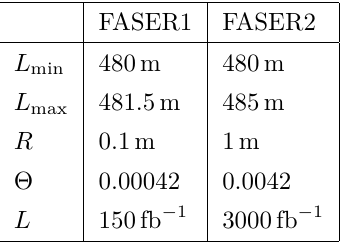
Table 2 . Geometrical parameters of FASER-I and FASER-II